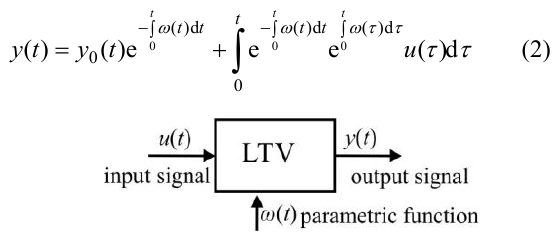
Fig. 1. Model of the first order LTV